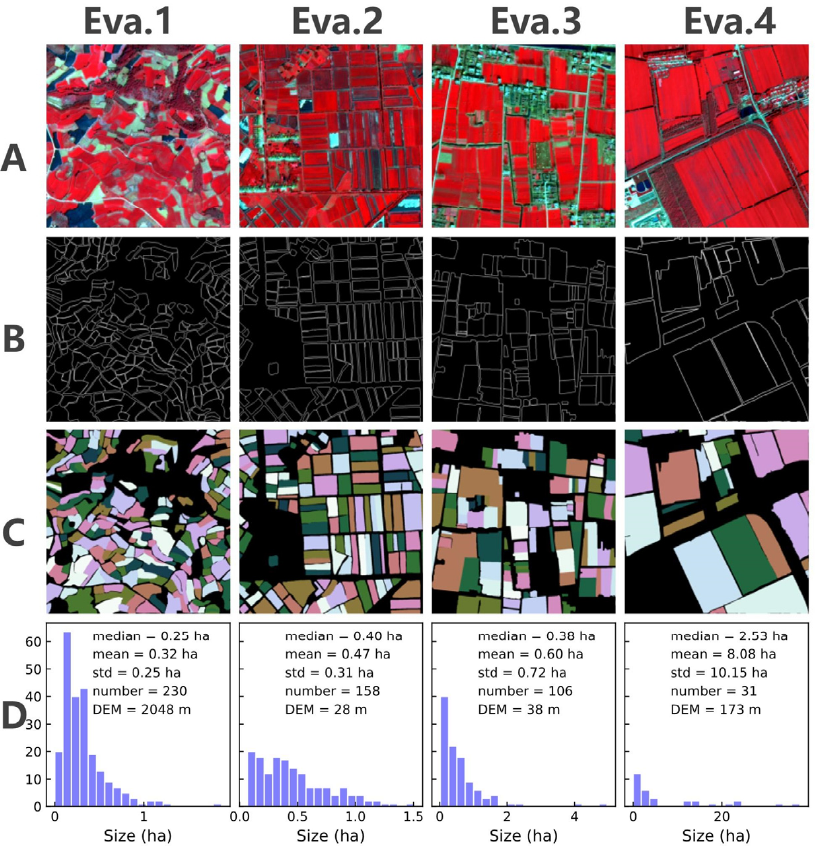
Figure 3. The four typical evaluation tiles and associated reference cropland parcels in this study. ( A ) The pseudo-color composition image of each tile, ( B ) boundaries of the reference cropland parcels, ( C ) individual cropland parcels denoted by random color, and ( D ) the cropland parcel size distributions and the topological characteristics over four tiles.